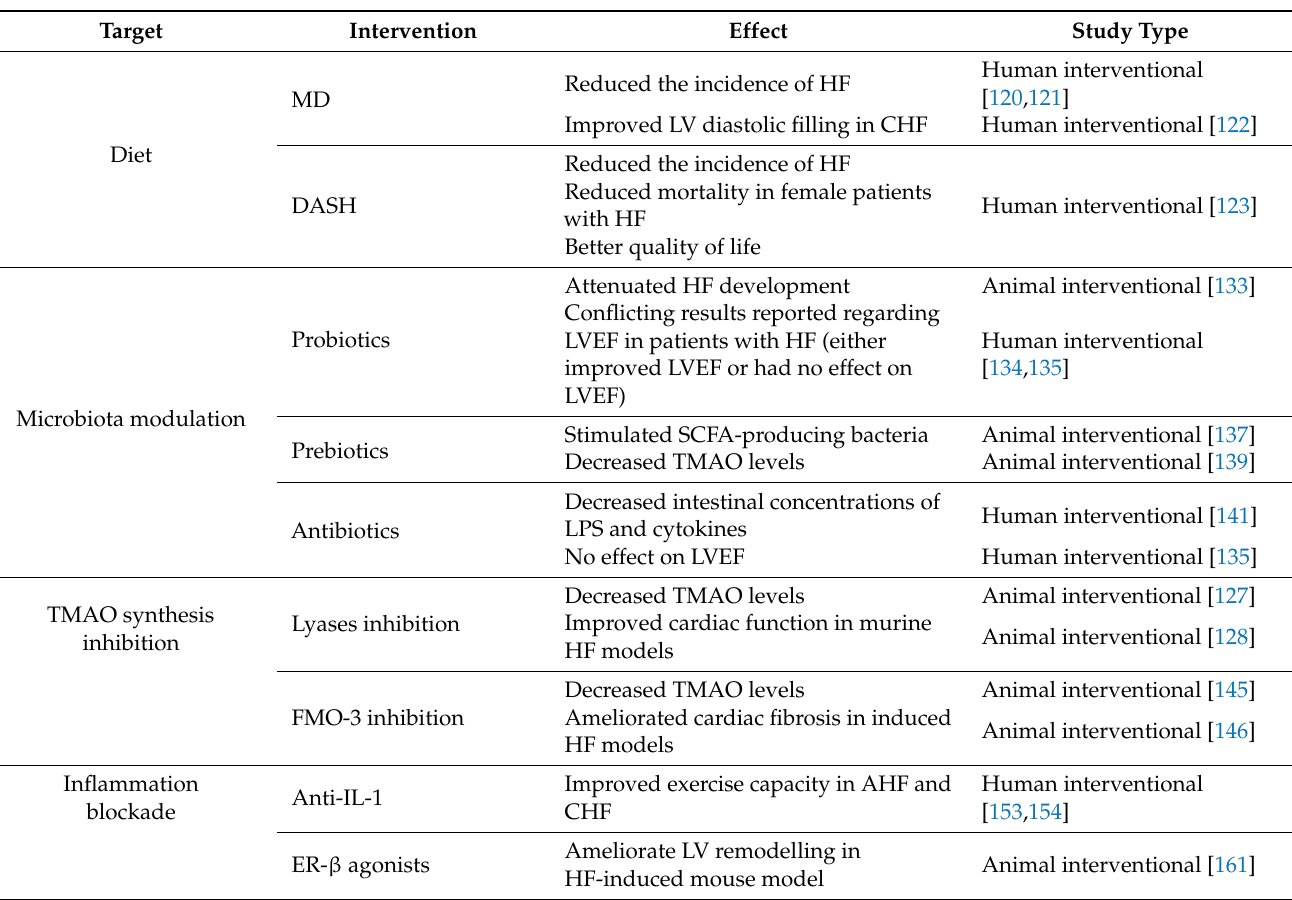
Table 1. Promising therapeutic targets aiming at gut–heart axis modulation in